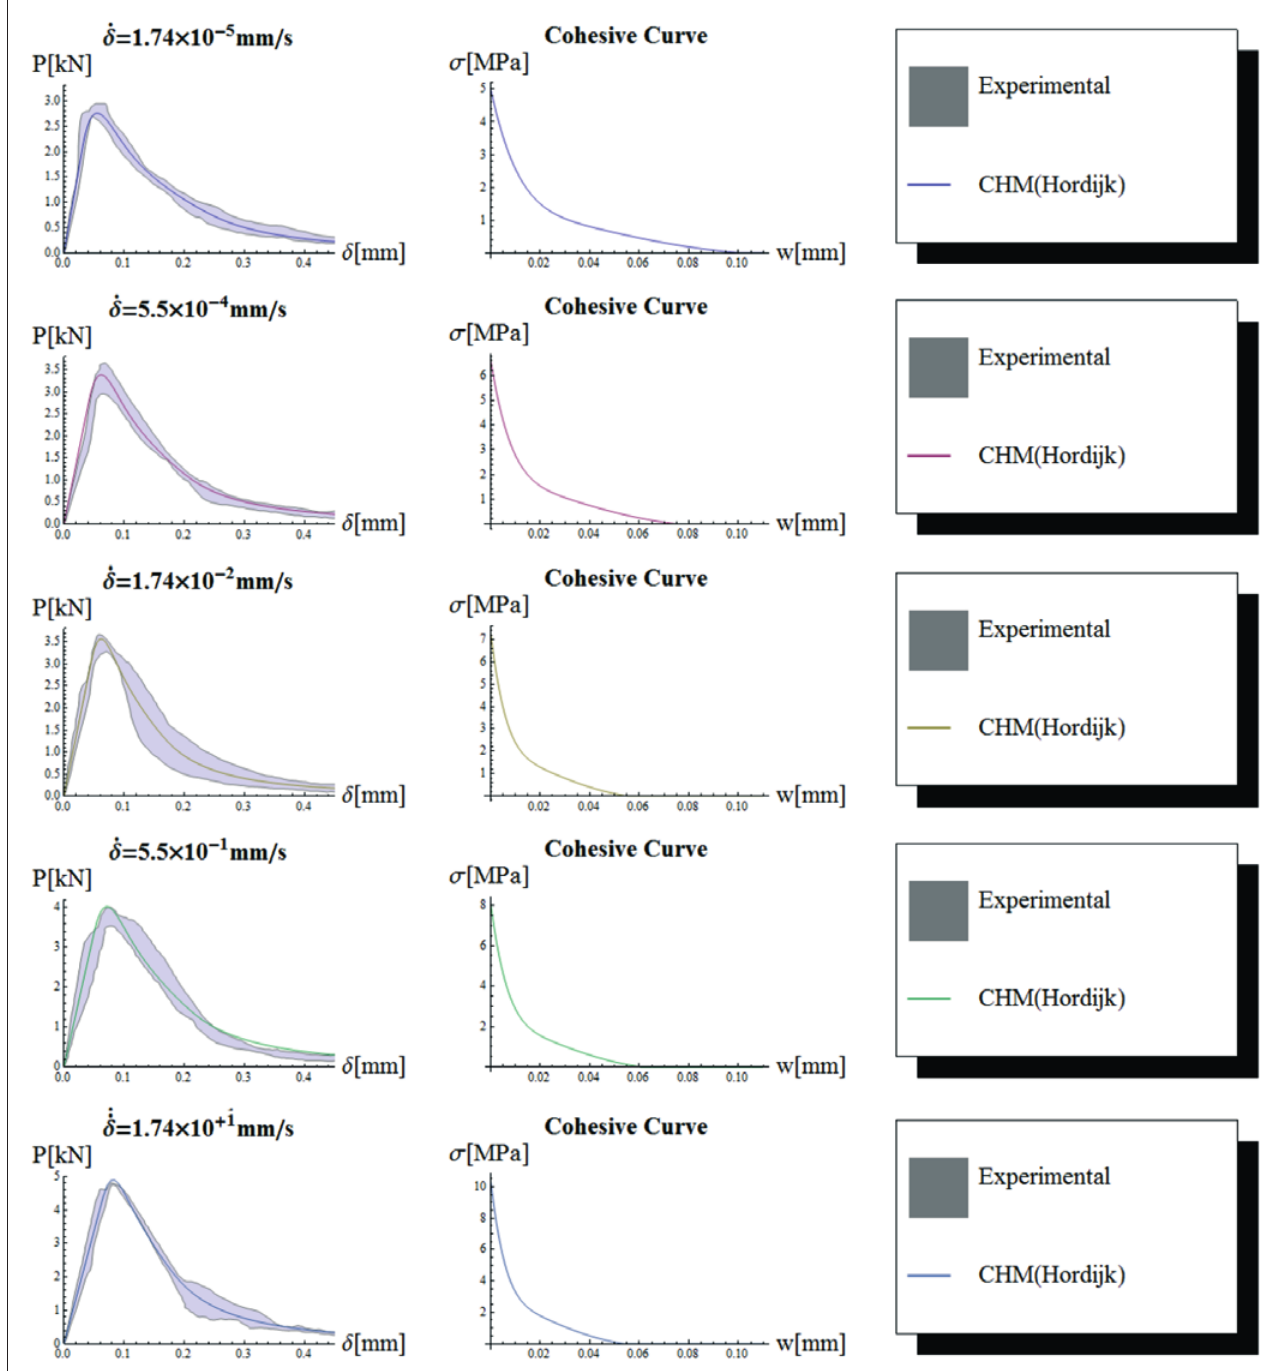
Figure 25 – Fit Hordijk (1991) [33] cohesive curve using the CHM for each experimental